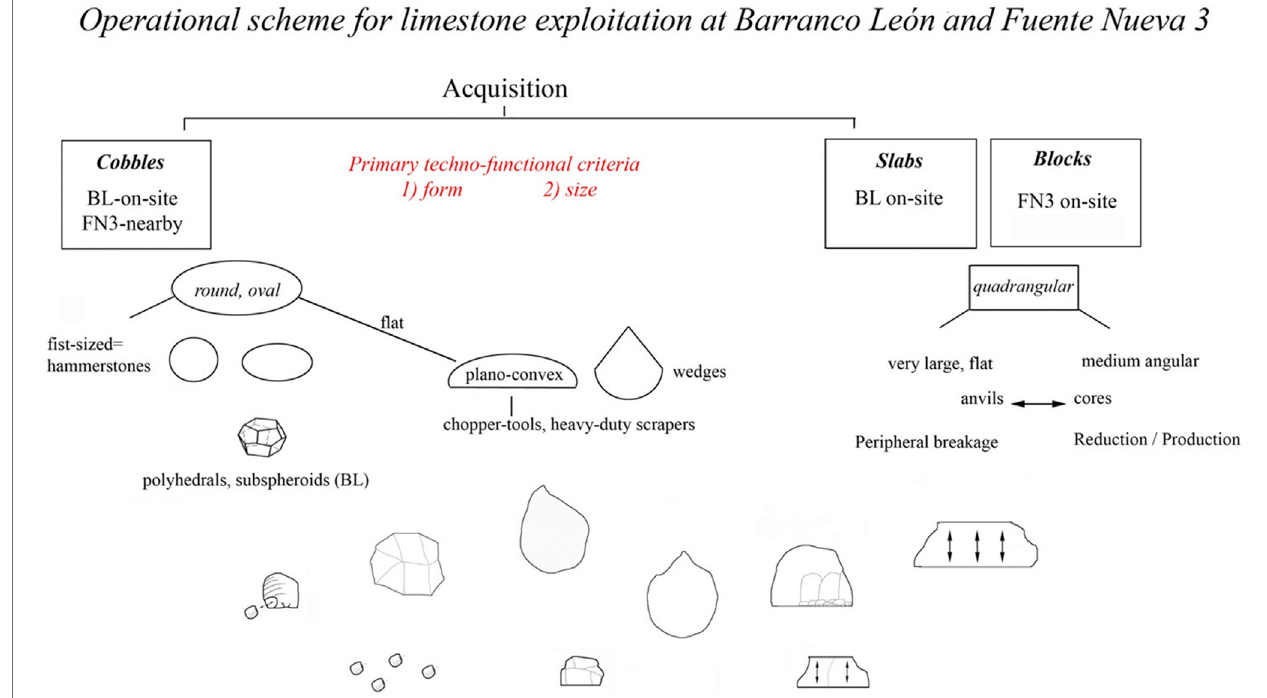
FIGURE 9 | Proposed operative schemes for the Barranco León and Fuente Nueva 3 limestone toolkits. Acquisition of clasts was in relation to primary techno- functional criteria (form and size). Typical use and/or reduction-production strategies revealing geometric morphometric choices relating to desired fi nal product. A speci fi c range of typical fi nal products is identi fi ed (by D.